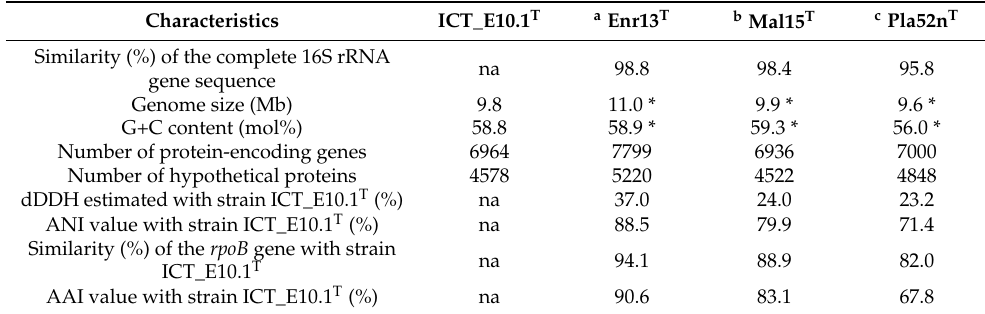
Table 1. Main genomic features of strain ICT_E10.1 T and data on the current validly described members of the genus Stieleria for comparison. Genomes of Stieleria neptunia Enr13 T , S. maiorica Mal15 T , and S. varia Pla52n T were re-annotated in this study with the same version of Prokka used for the genome of strain ICT_E10.1 T .